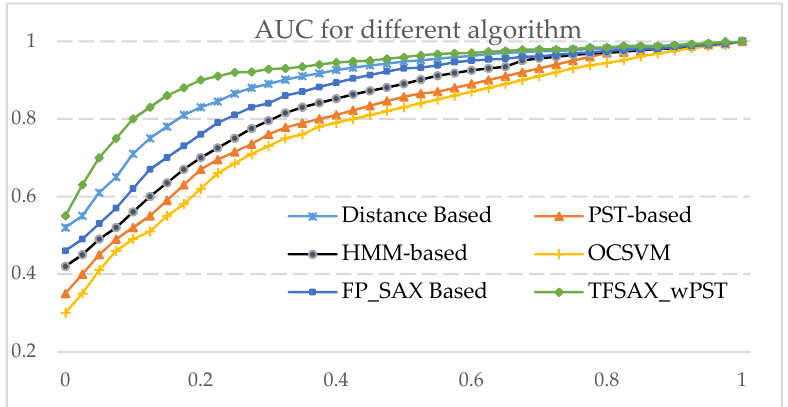
Figure 10. AUC for the different algorithms.